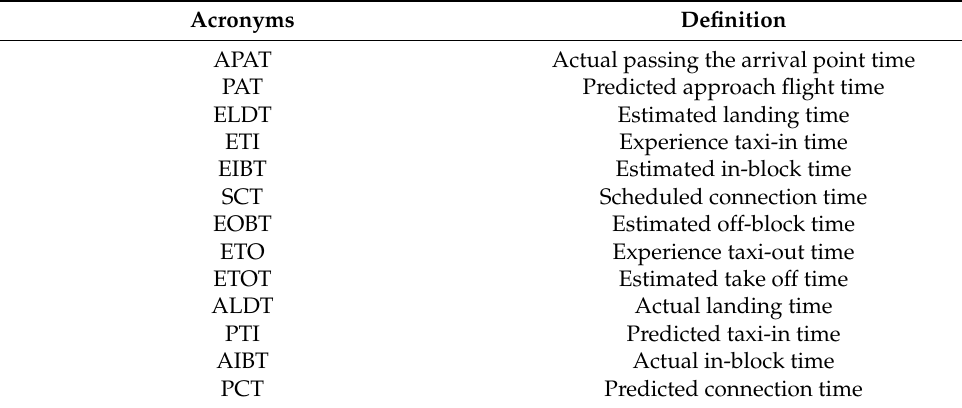
Figure 4. ML-DM model implementation process. Table 1. Acronyms in the implementation process of ML-DM model.